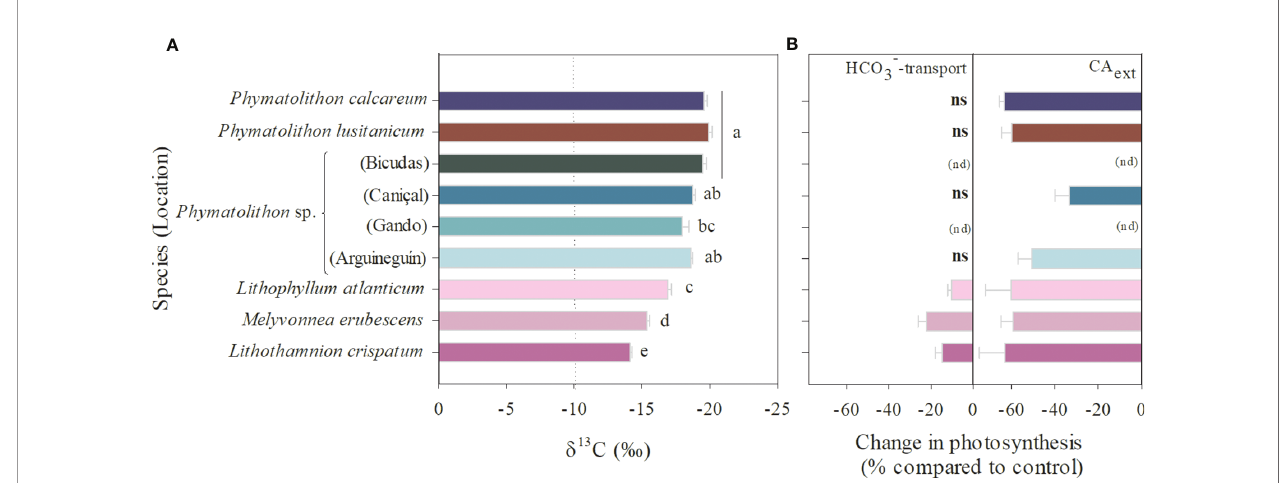
FIGURE 5 | DIC-uptake strategies in Atlantic rhodolith species. (A) d 13 C values, with signi fi cant differences among species (ANOVA, Tukey ’ s HSD posthoc, p<0.05) indicated by different letters (dotted line indicates the threshold, with values above indicating HCO 3 – only users), and (B) importance of active bicarbonate transport and external carbonic anhydrase activity for photosynthesis (expressed as signi fi cant changes before and after treatment with the respective inhibitors, paired sample t -test, p<0.05, Supplementary Table S3 ) (ns - not signi fi cant, nd - not determined). Data represent mean ± SE (n=5).